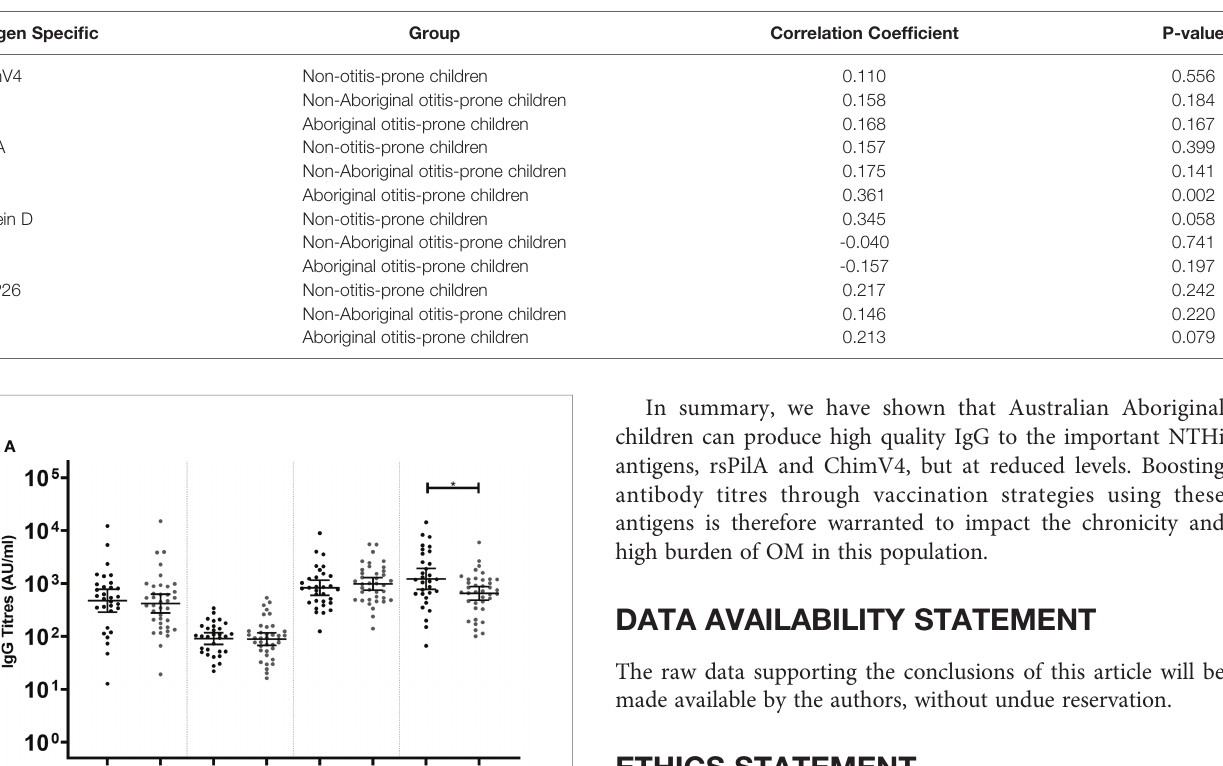
TABLE 4 | Correlation of antigen speci fi c IgG RAI and IgG titres.